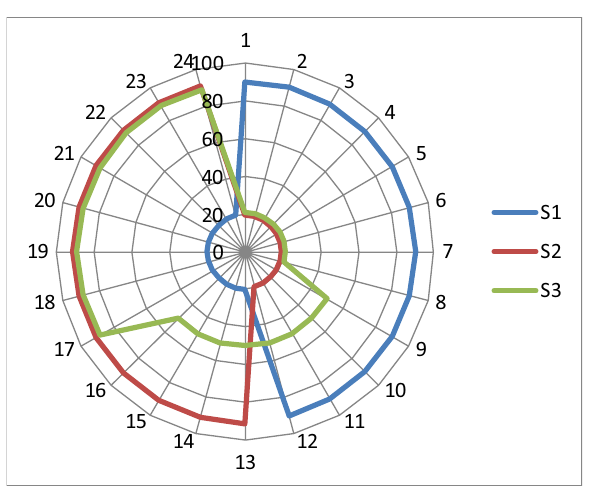
Fig. 3 Starting oil flow rates (tn/day) of every well of a 24-well pad for three scenarios S1, S2 and S3 (numbers 1 to 24 enumerate wells, with flow rates being measured along the radial direction) Table 2 The reference and the initial designs for three drilling scenar- ios (well pad configurations are shown in curly brackets, and a num- ber of wells in every cluster are separated by commas) Design\Scenario S1 S3